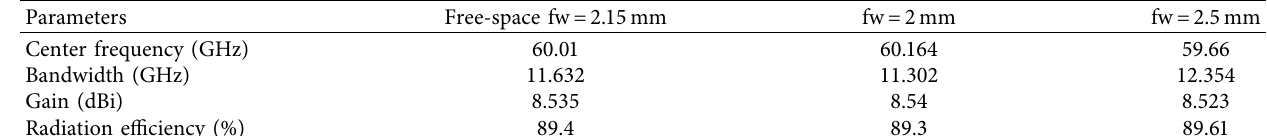
Table 3: Feedline width (fw) changes.